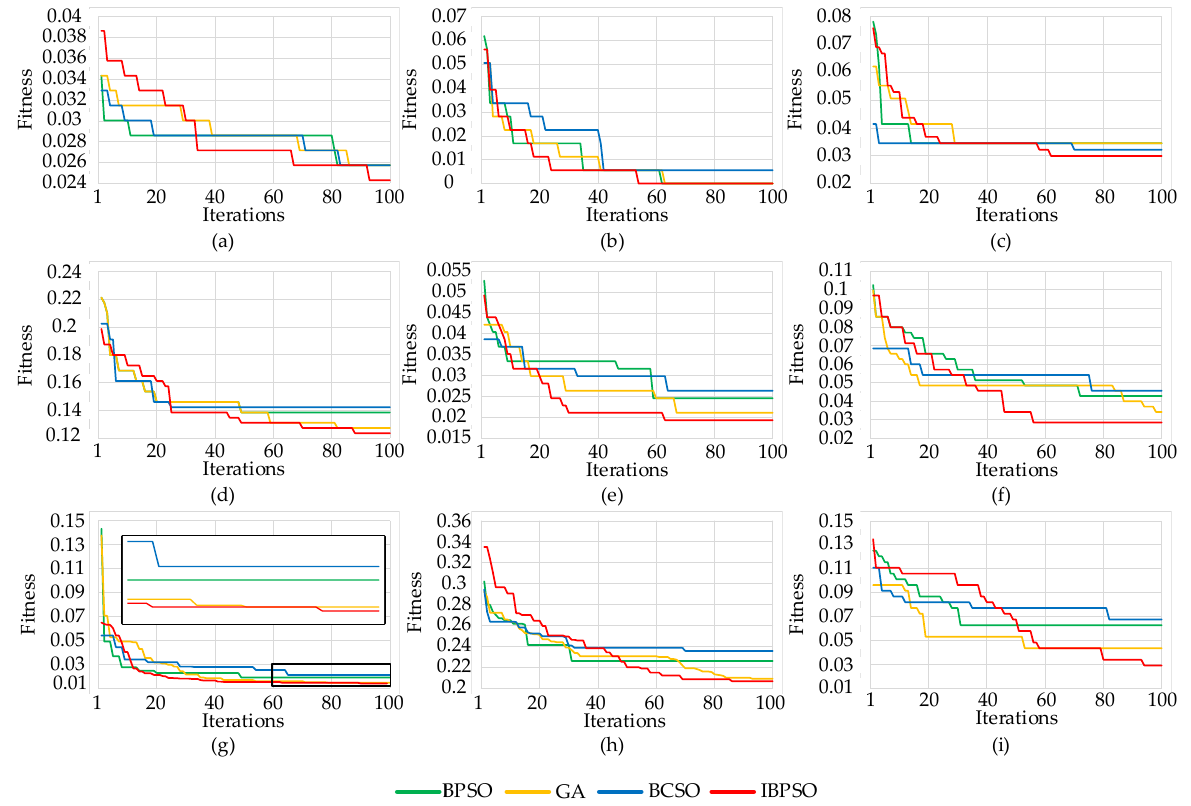
Figure 3. Comparison between IBPSO based on convergence curves of UCI benchmark datasets. ( a ) BreastCancer, ( b ) Wine, ( c ) CongressEW, ( d ) SpectEW, ( e ) BreastEW, ( f ) Ionosphere, ( g ) krvskp, ( h ) WaveformEW, ( i ) Sonar.